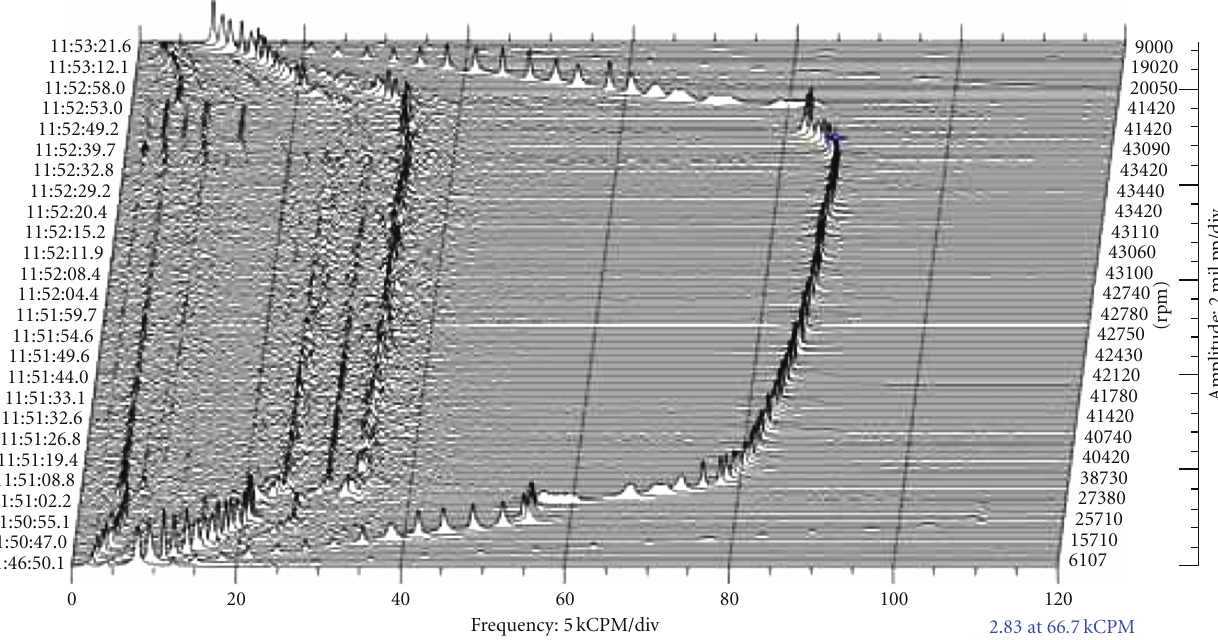
Figure 14: Compressor vertical probe frequency content Residual imbalance Run 14, 86, 700rpm max speed [2].